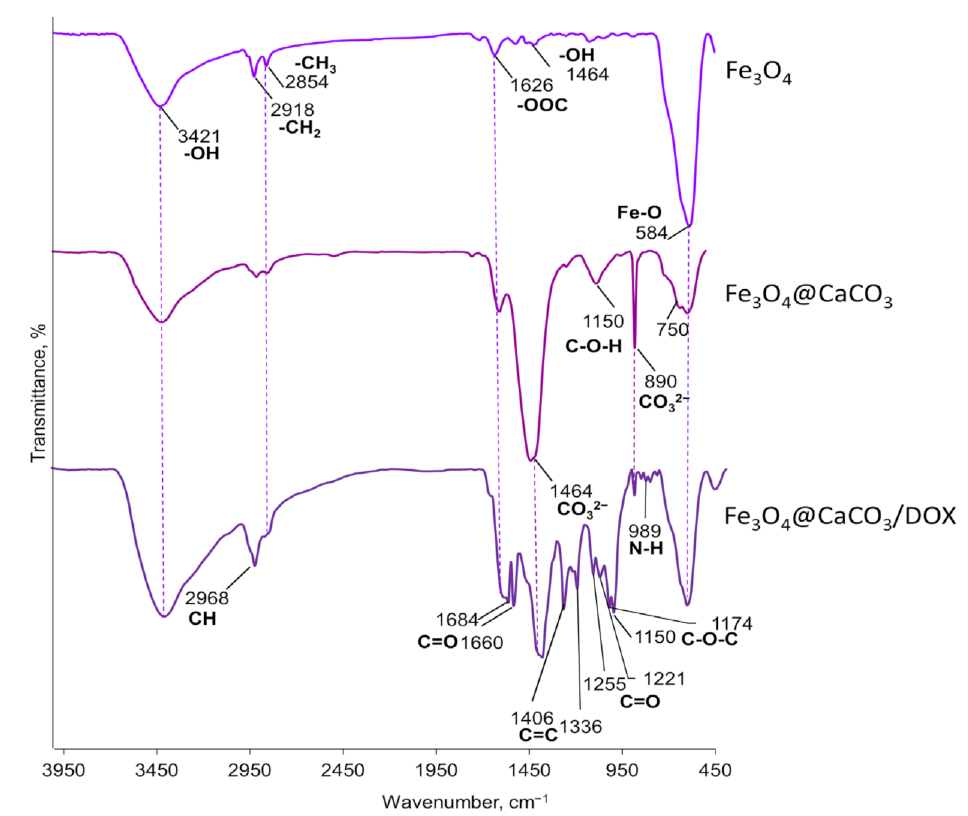
Figure 4. FTIR spectra of Fe 3 O 4 , Fe 3 O 4 @CaCO 3, and Fe 3 O 4 @CaCO 3 /DOX